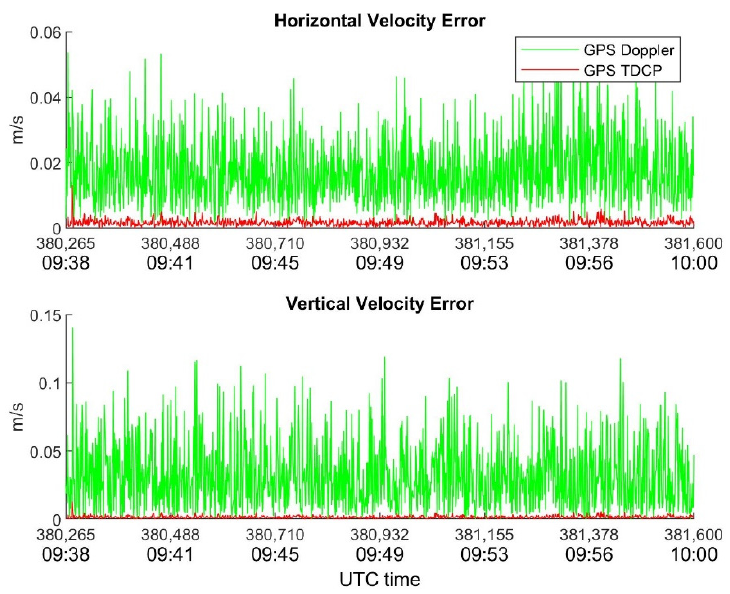
Figure 7. Novatel horizontal and vertical velocity errors as function of time. RAIM is applied.